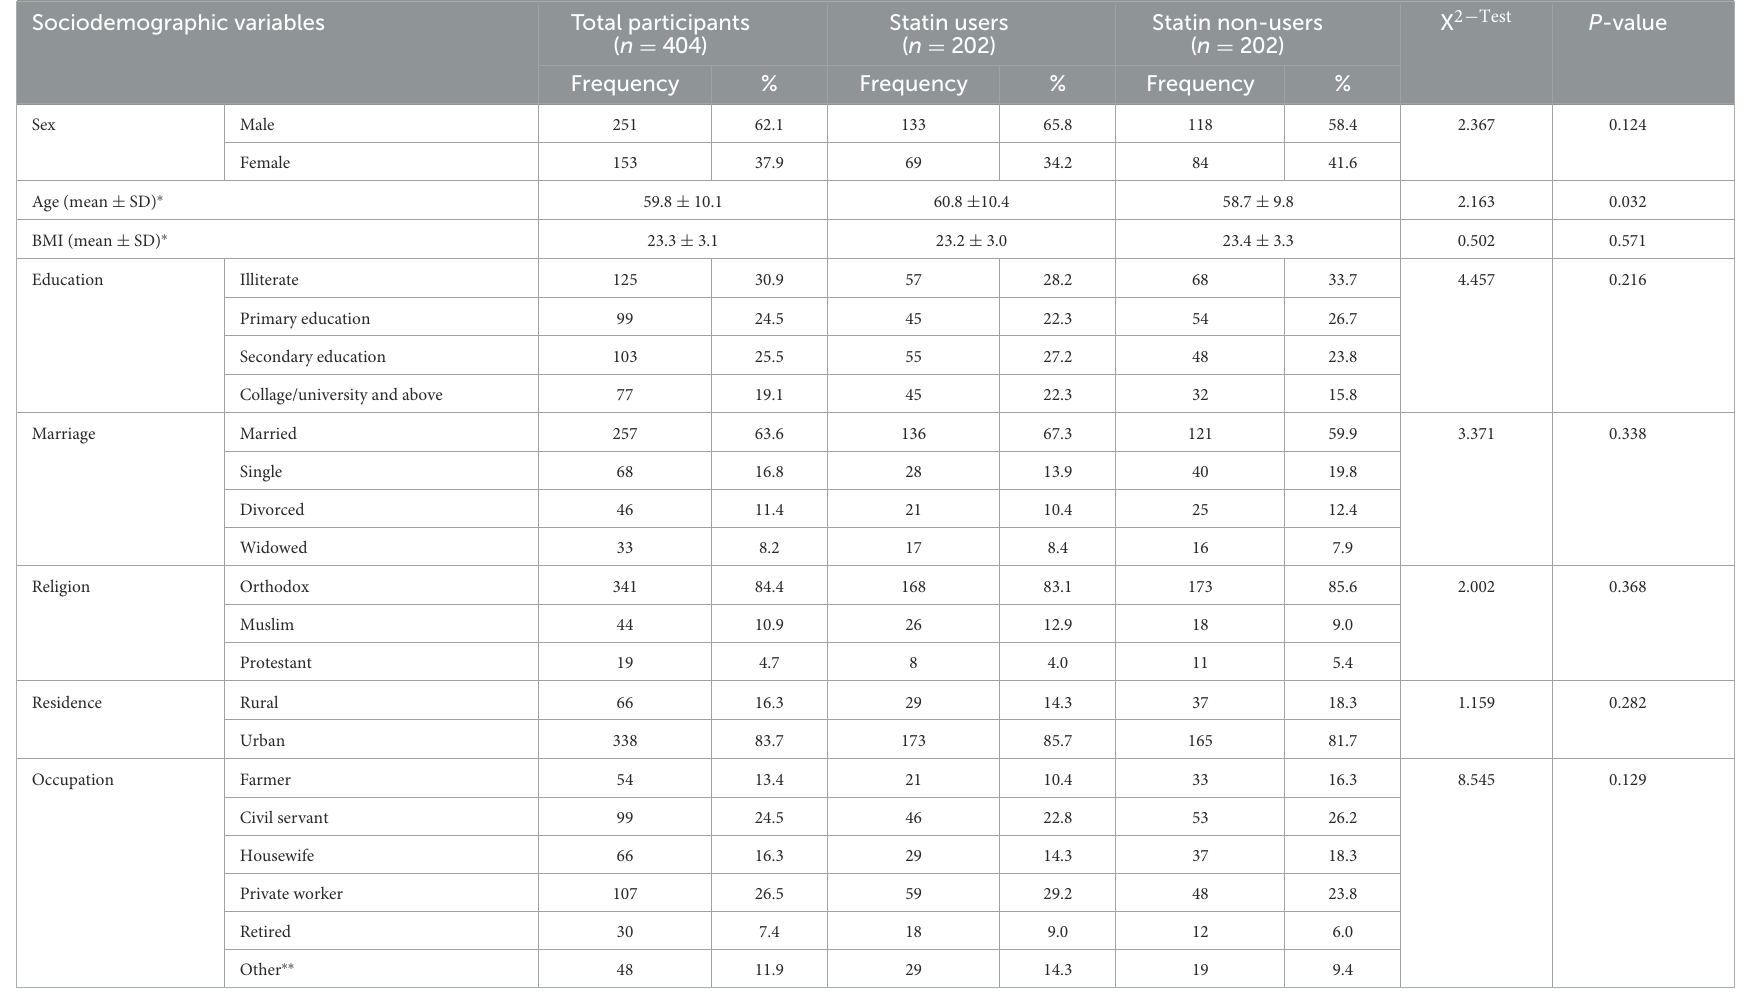
TABLE 1 Sociodemographic features of patients with hypertension attending the outpatient clinic at FHCSH, northwest Ethiopia. Sociodemographic variables Total participants